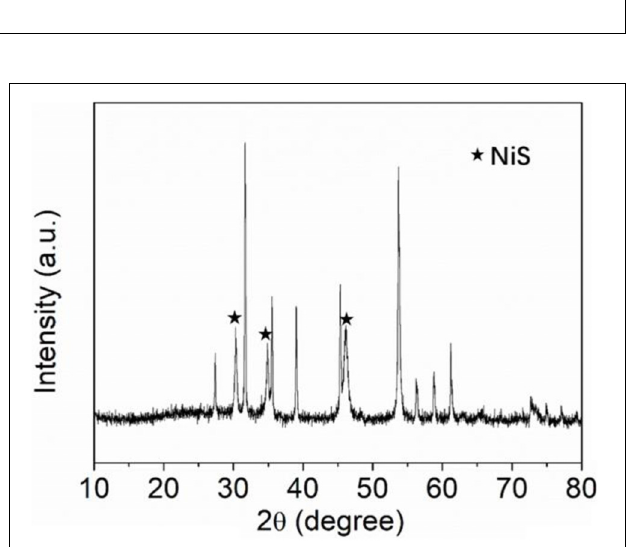
FIGURE 3 | XRD pattern of Ni x S y